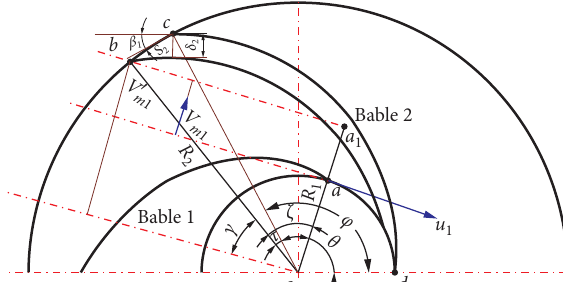
Figure 17: Design diagram of the wrap angle.